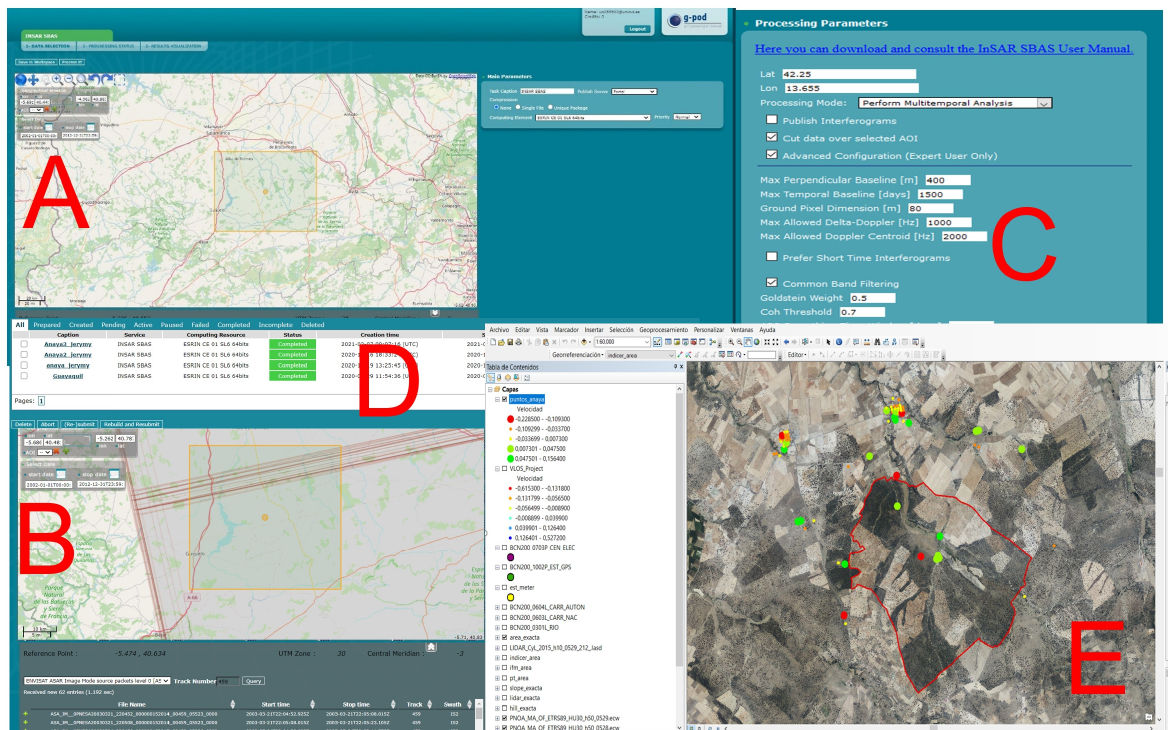
Figure 5. ( A ). Selection of the study area for the subsequent search and processing of SAR images. ( B ). Choice of the track number and display of the images to be processed. ( C ) Parameters chosen for image processing. ( D ). Process control and processing status. ( E ) Displacement mapping obtained in the study area.